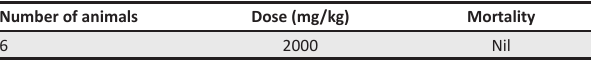
TABLE 1: Result of acute toxicity assay of ethanolic leaf extract of Combretum micranthum at a dose of 2000 mg/kg using Organization for Economic Cooperation and Development method.